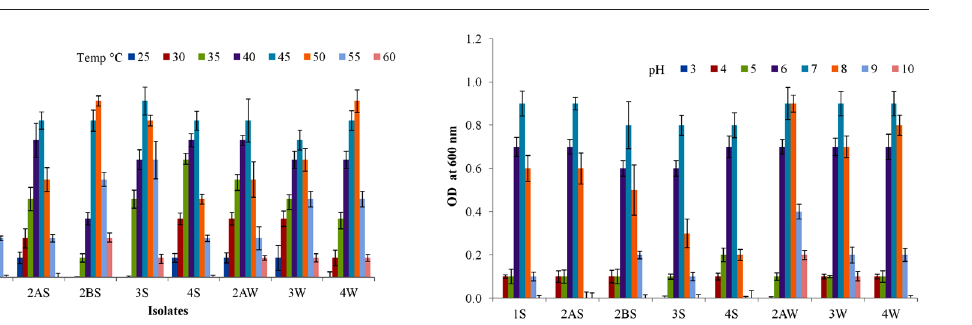
Fig. 2. Growth profile of isolates at various temperature range 25-60 (°C) for 24 h.